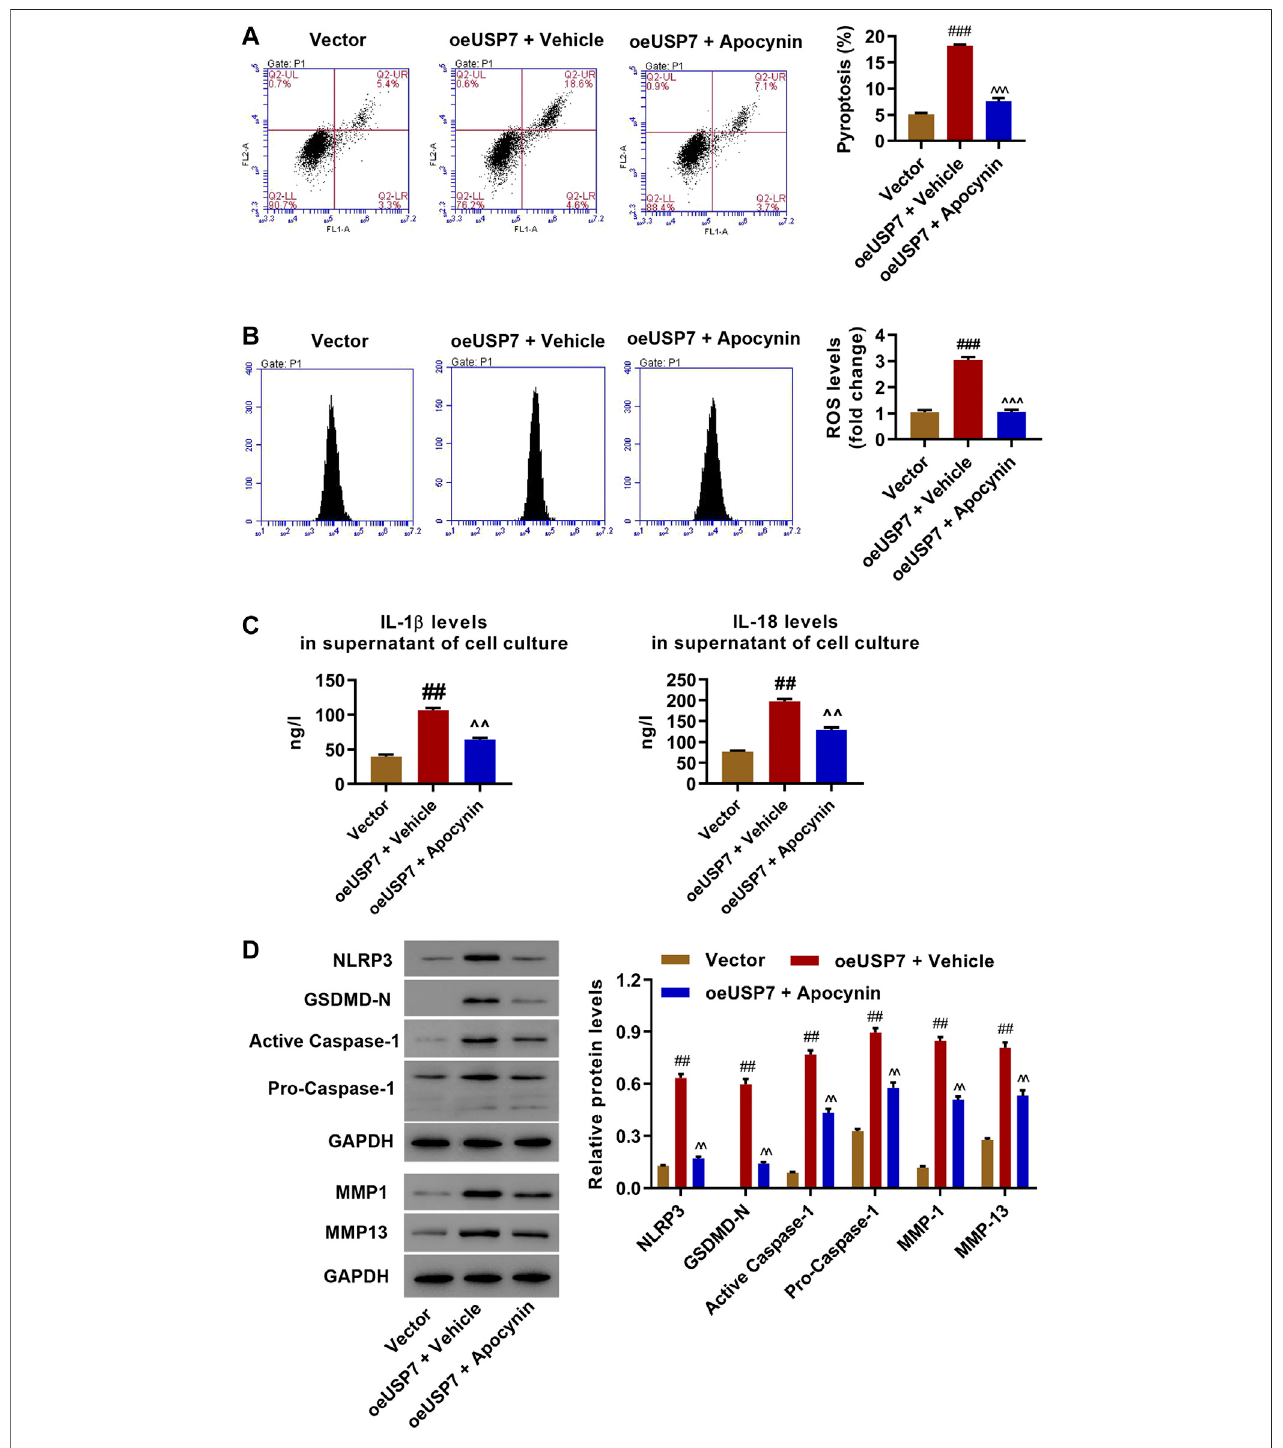
FIGURE 3 | USP7 overexpression promoted injury in rat chondrocytes through increasing ROS production. Rat chondrocytes were transduced with the USP7 expression vector and treated with ROS inhibitor 50 μ M apocynin, and (A) pyroptosis, (B) ROS production, (C) IL-1 β and IL-18 levels, and (D) expression levels of NLRP3, GSDMD-N, active caspase-1, pro-caspase-1, MMP1, and MMP13 was measured by fl ow cytometry, ELISA, and Western blot, respectively. ### p < 0.001 vs vector; ^^^ p < 0.001 vs oeUSP7 + vehicle.